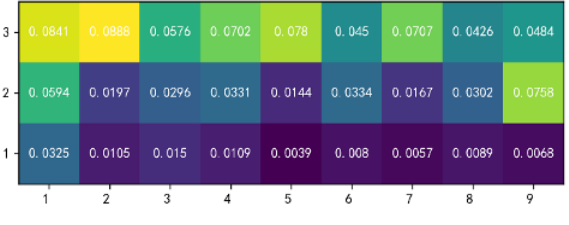
Fig. 4. Personnel distribution density of subway station platform during morning peak( τ = 10